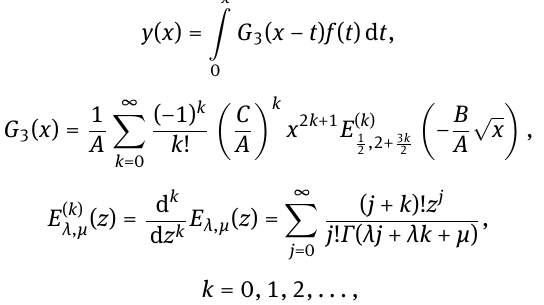
Fig. 3: Comparison of y ( x ) for h = 1 , N = 30 and α = 1.25, 1.5, 1.75 with exact solutions for Example 1.